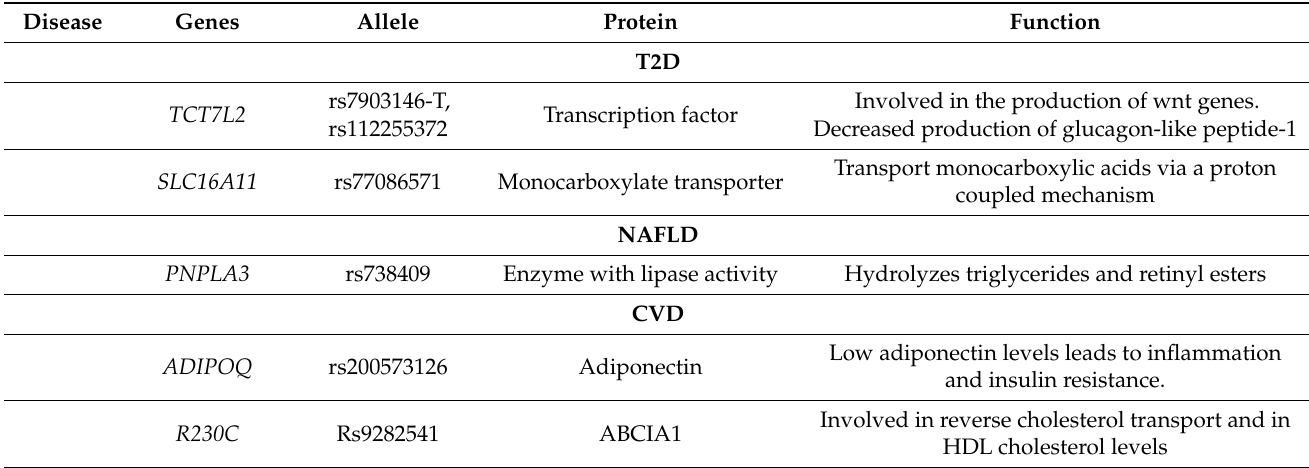
Table 1. Selected gene variants associated with type 2 diabetes (T2D), cardiovascular disease (CVD), and non-alcoholic fatty liver disease (NAFLD) in